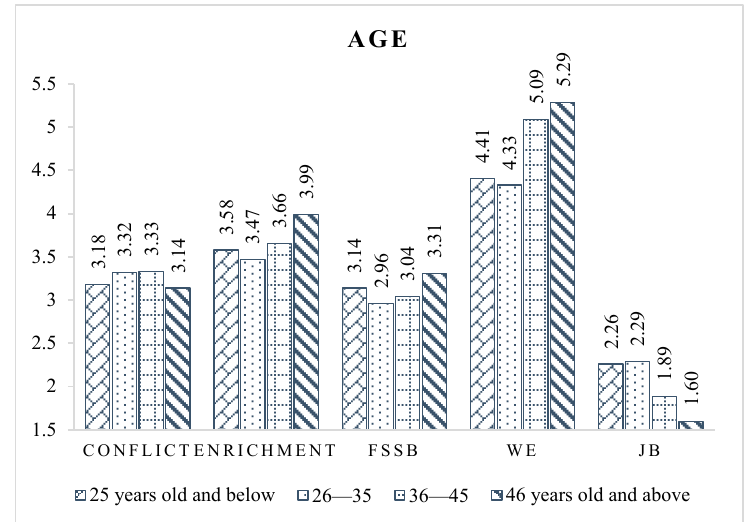
Figure 2. Latent variable scores of different age groups.